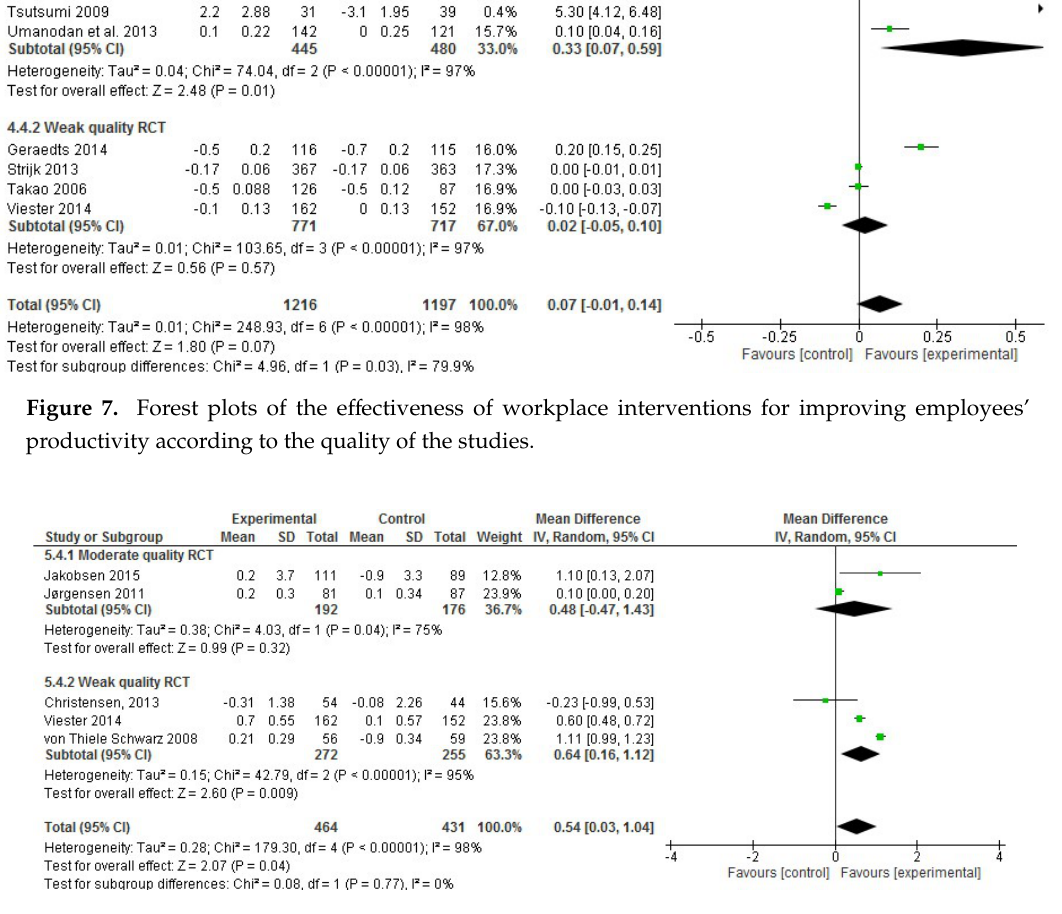
Figure 7. Forest plots of the effectiveness of workplace interventions for improving employees’ productivity according to the quality of the studies.